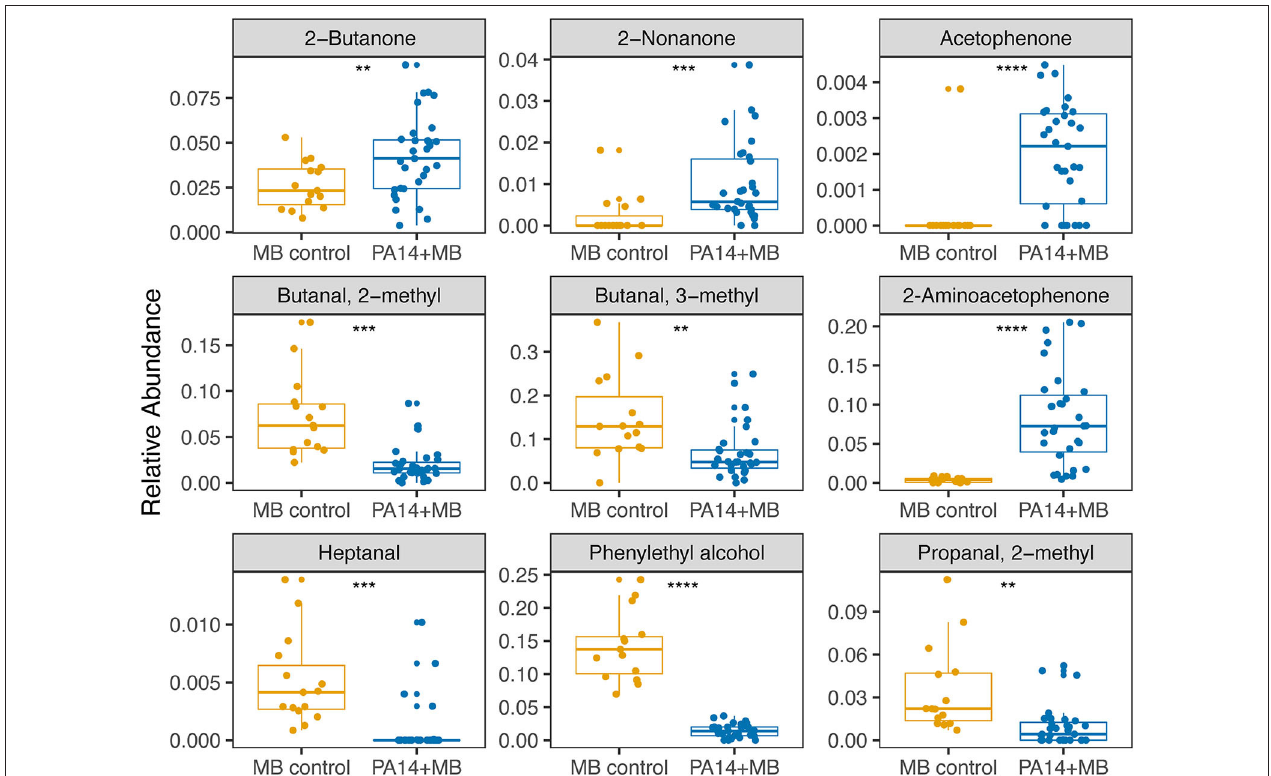
FIGURE 7 | Relative abundances of metabolites significantly different between PA14 + MB and MB control communities. PA14 + MB represents the microbial community on a meat sample with both PA14 and MB(PA14) populations. The MB control community is a meat sample with only the meat microbial background. The relative abundances are values resulting from normalizing by total sample intensity. Each point represents a biological sample. All treatments are represented in this figure. Statistical testing was performed with T -tests. Significance is indicated by asterisks. ** p < 0.01; *** p < 0.001; **** p < 0.0001.